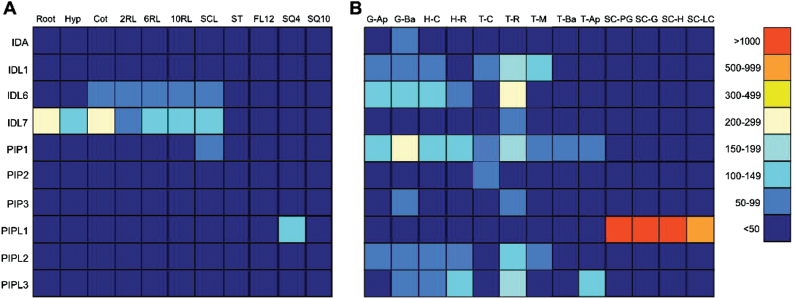
Developmental expression patterns of IDA/IDL and PIP/PIPL genes based on in silico data. (A) Expression in different vegetative tissues during development. (B) Expression during embryo and seed development (Casson et al., 2005). All data was obtained from the Arabidopsis eFP browser at the Bio-Array Resource database (Winter et al., 2007). The arithmetic expression values are given next to the colour scale. Hyp, hypocotyl; Cot, cotyledon; 2RL, second rosette leaf; 6RL, sixth rosette leaf; 10RL, tenth rosette leaf; SCL, senescing leaves; ST, stem; FL12, flower stage 12; SQ4, silique position 4; SQ10, silique position 10; G-Ap, globular stage apical; G-Ba, globular stage basal; H-C, heart stage cotyledon; H-R, heart stage root; T-C, torpedo stage cotyledon; T-R, torpedo stage root; T-M, torpedo stage meristem; T-Ap, torpedo stage apical; T-Ba, torpedo stage basal; SC-PG, seed coat preglobular stage; SC-G, seed coat globular stage; SC-H, seed coat heart stage; SC-LC, seed coat linear cotyledon.